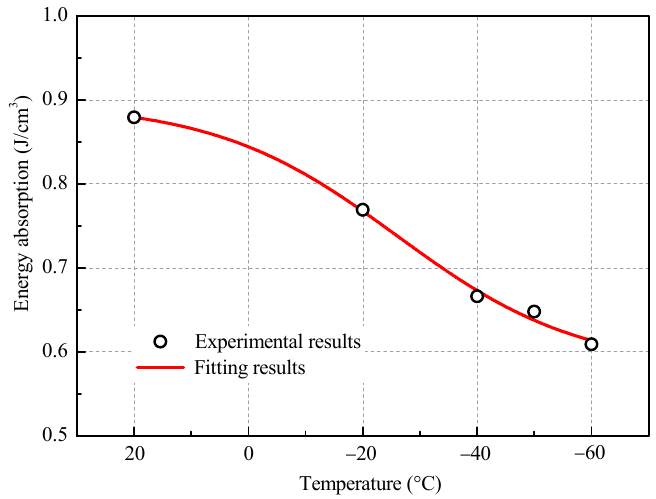
Figure 10. Variation of dynamic energy absorption with freezing temperature.